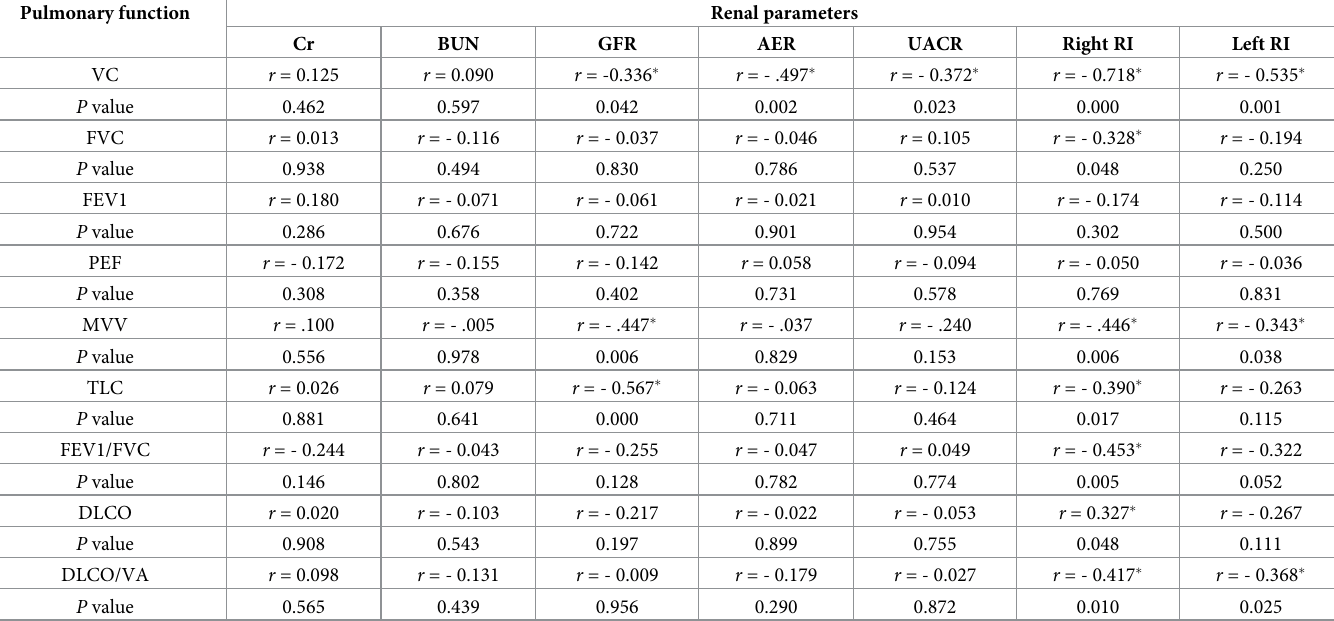
Table 4. Correlation between pulmonary function parameters and renal parameters in diabetes group.